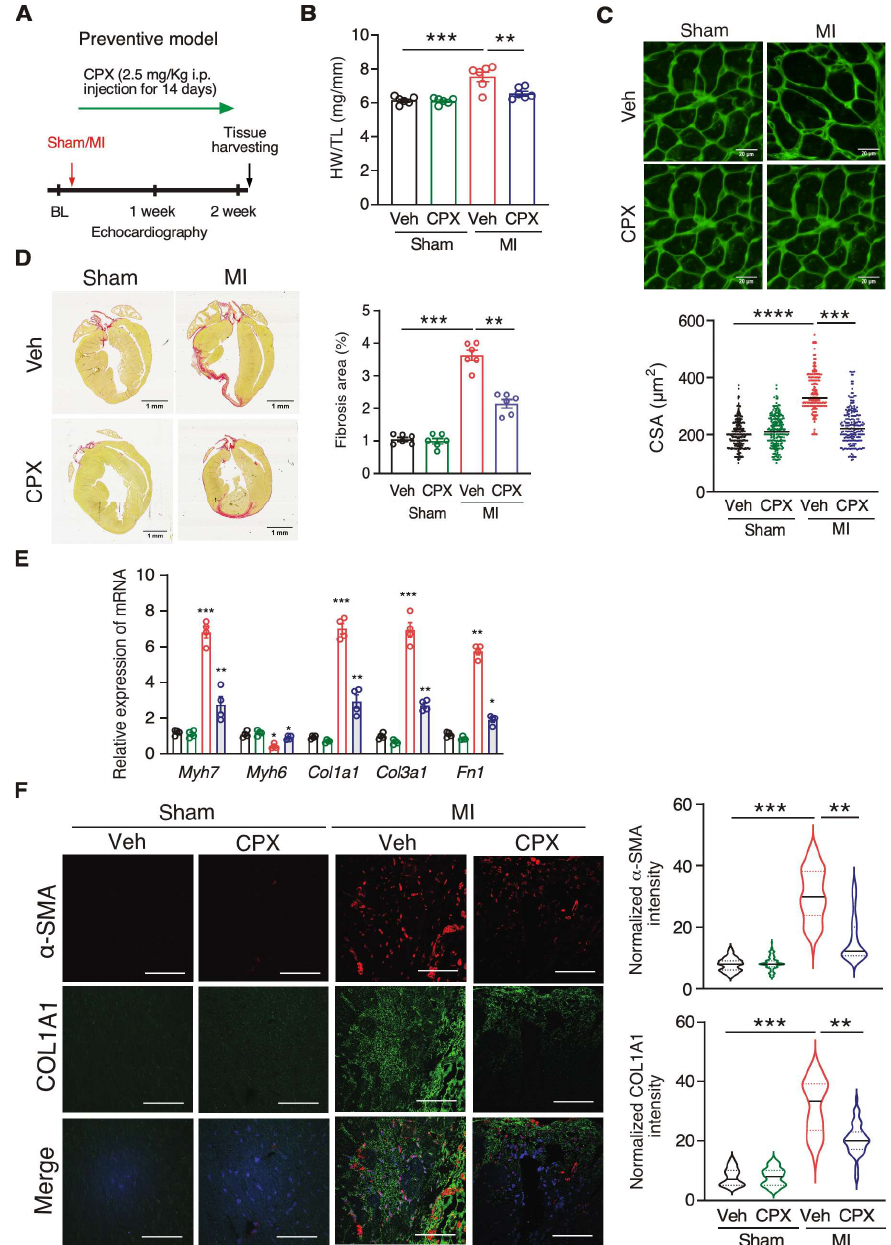
Figure 2. Ciclopirox antagonizes cardiac hypertrophy and fibrosis after MI in a preventive model. ( A ) Schematic of a preventive model using CPX to treat MI in mice. ( B ) Reduced HW/TL ratio in 2-week MI mouse HF model compared to vehicle-treated mice. n = 9/9/7/9 for the four groups of Veh Sham/CPX Sham/Veh MI/CPX MI. ( C ) Wheat germ agglutinin staining of the vehicle and CPX-treated mice with sham or MI surgery. The cross-sectional area (CSA) of CMs was measured and quantified. n = 6 hearts per group with 50–100 CMs measured per heart. Scale bar: 20 μM. ( D ) Picrosirius red staining indicates a decreased fibrotic area in the hearts of CPX-treated mice after MI surgery. Scale bar: 1 mm. n = 6 for all the groups. ( E ) RT-qPCR measurement of expression of cardiac hypertrophy and fibrosis marker mRNAs. 18S rRNA was used as a normalizer. n = 4 for all the groups. ( F ) α -SMA and COL1A1 protein expression in heart tissues of the vehicle and CPX-treated mice with sham or MI surgery. n = 5 hearts per group with >300 CFs measured per heart. Scale bar: 50 µ M. * p < 0.05, ** p < 0.01, *** p < 0.001, **** p < 0.0001 by Two-way ANOVA with Tukey’s multiple comparisons